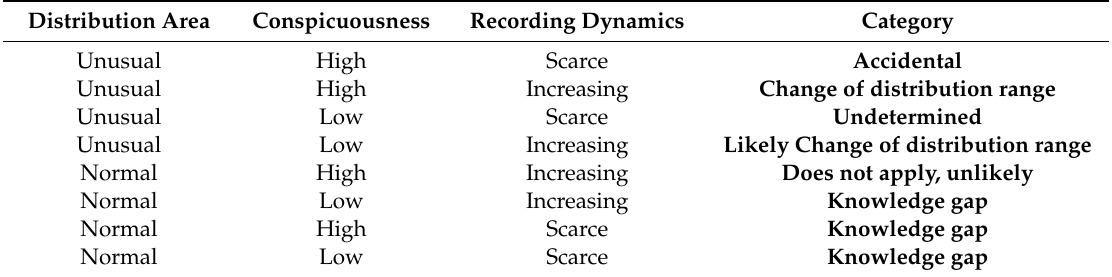
Table 3. Combinations of indicators used to classify species into di ff erent categories for the new records of birds in the Ecuadorian part of the Tumbesian region in the last two